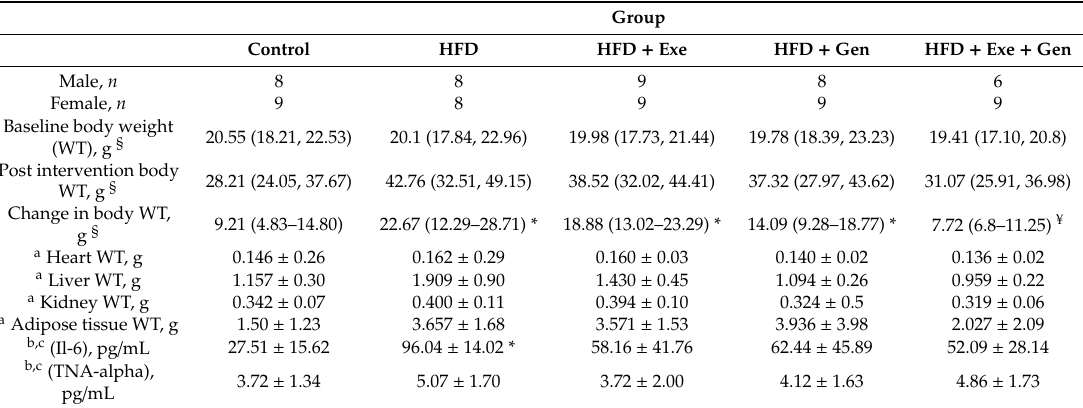
Table 2. Phenotype characteristics.